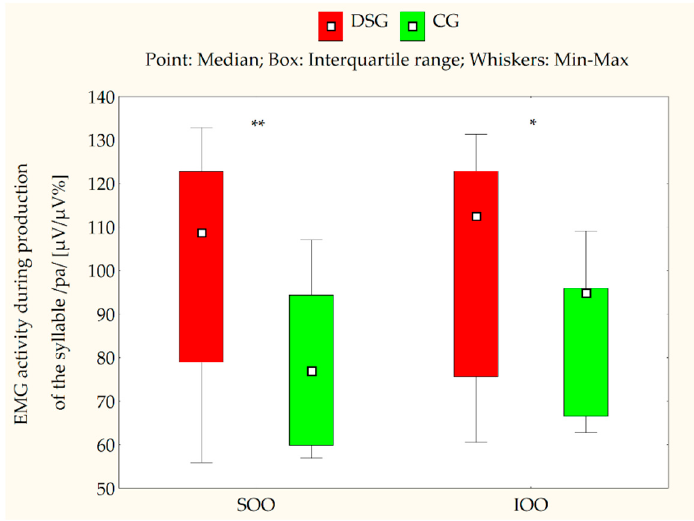
Figure 4. EMG activity of the superior orbicularis oris (SOO) and inferior orbicularis oris (IOO) muscles (µV/µV%) during the production of the syllable /pa/ in the Down syndrome group (DSG) and the control group (CG); ** p < 0.01 for SOO; * p < 0.05 for IOO.